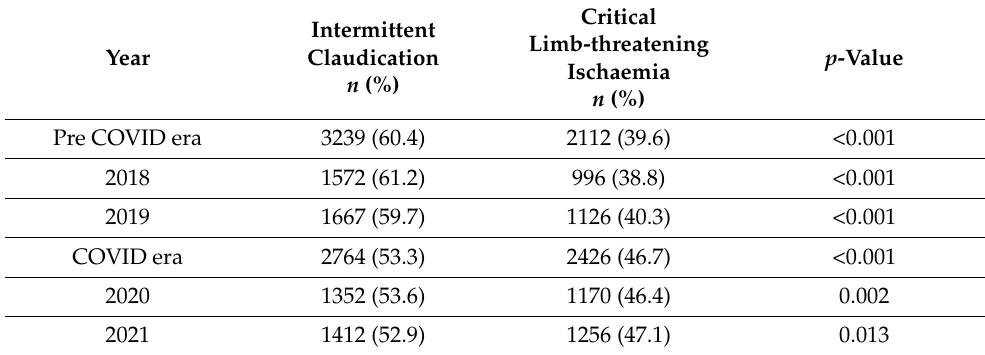
Table 2. Distribution of indications for endovascular intervention comparing the study